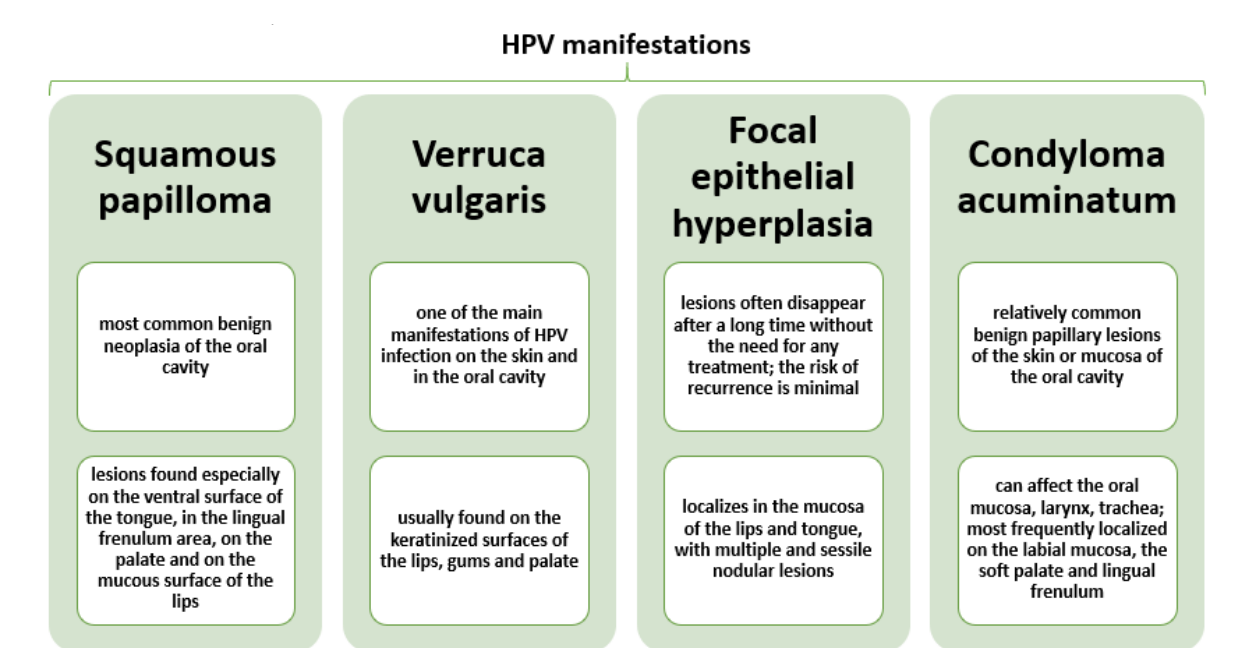
Figure 3. Characterization of most frequent HPV oral clinical manifestations. Created based on information from reference [32].